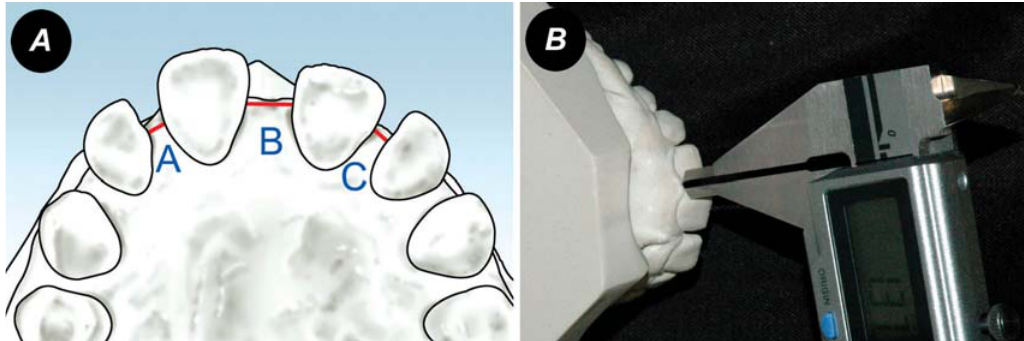
Figure 1- (1A) Sites where diastema widths were measured. A: Right lateral diastema; B: midline diastema; C: Left lateral diastema. (1B) Space width measurement using a round digital